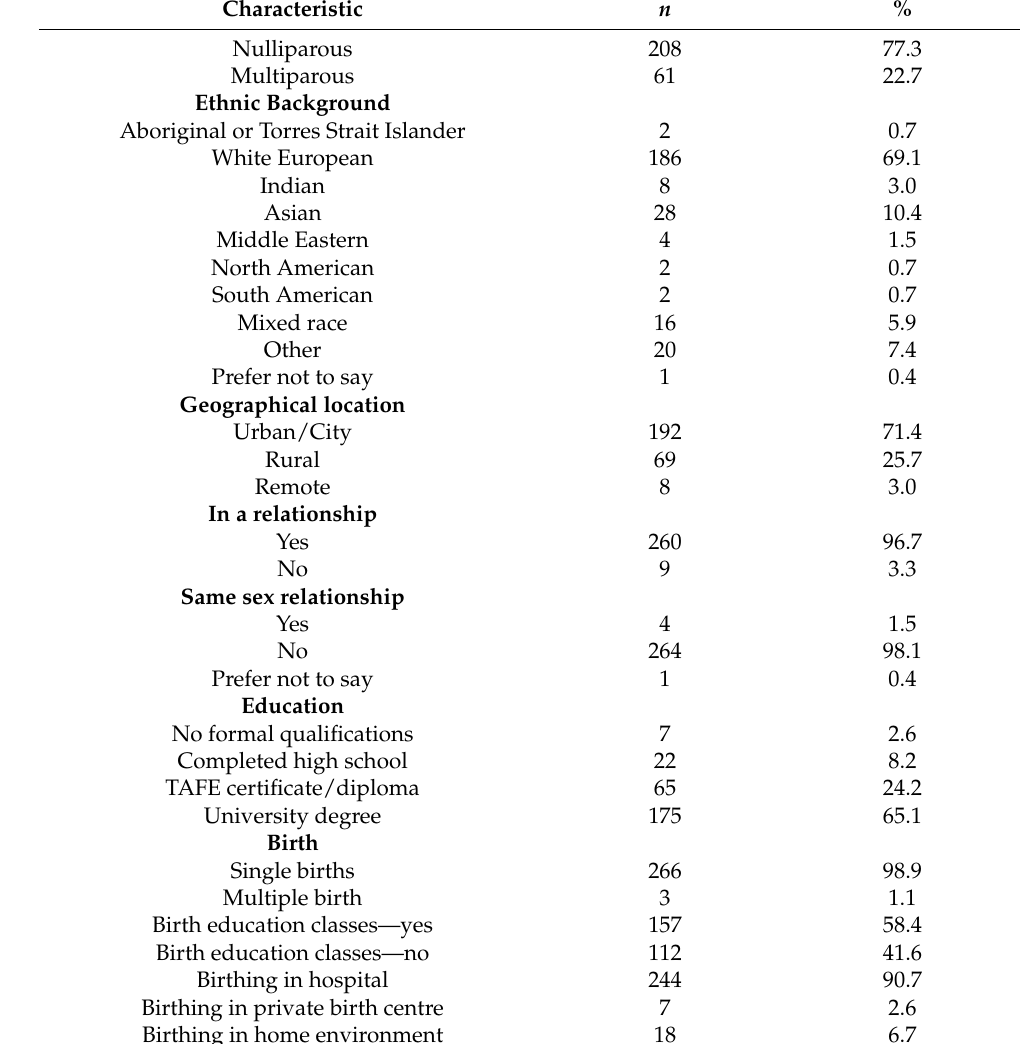
Table 1. Sample Characteristics ( N =